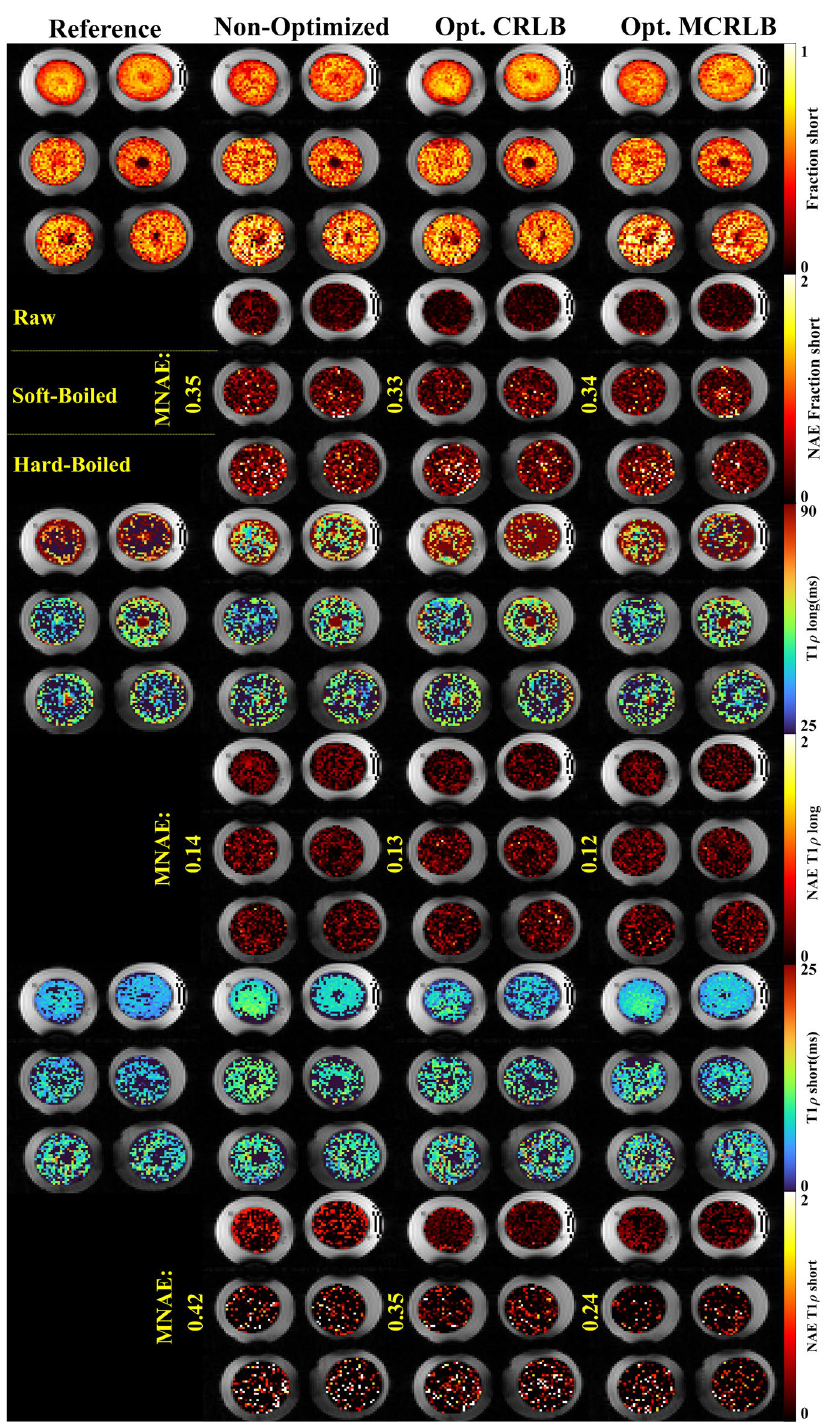
Figure 3. Bi-exponential parameter maps for the egg yolk phantom, the eggs are organized in rows as raw, soft-boiled, and hard-boiled, top-to-bottom order. The parameters fraction, long and short T 1ρ , along with the voxel-wise Normalized Absolute Error (NAE) for each parameter. Image created using Matlab 27 and Inkscape 28